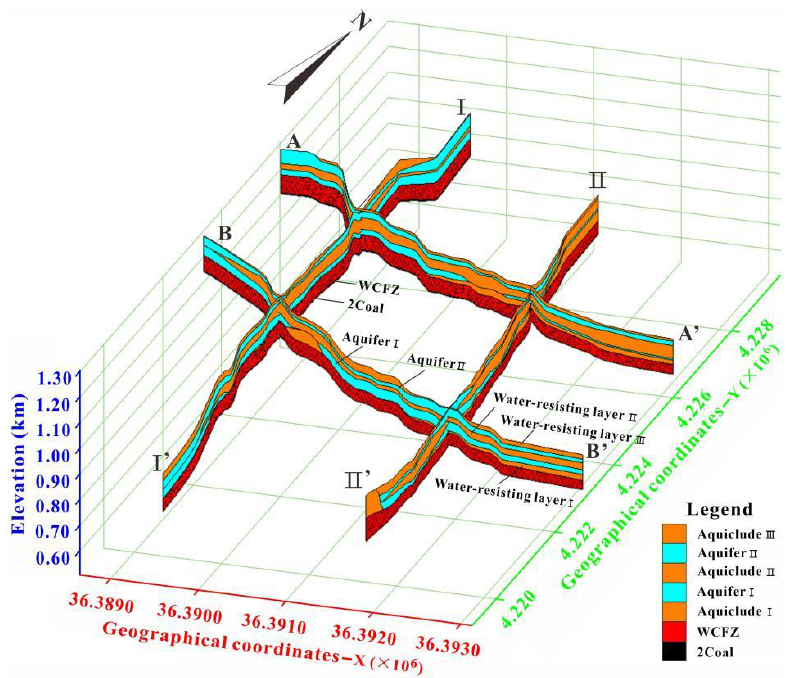
Figure 7. 3D hydrogeological structure section of WFCZ.